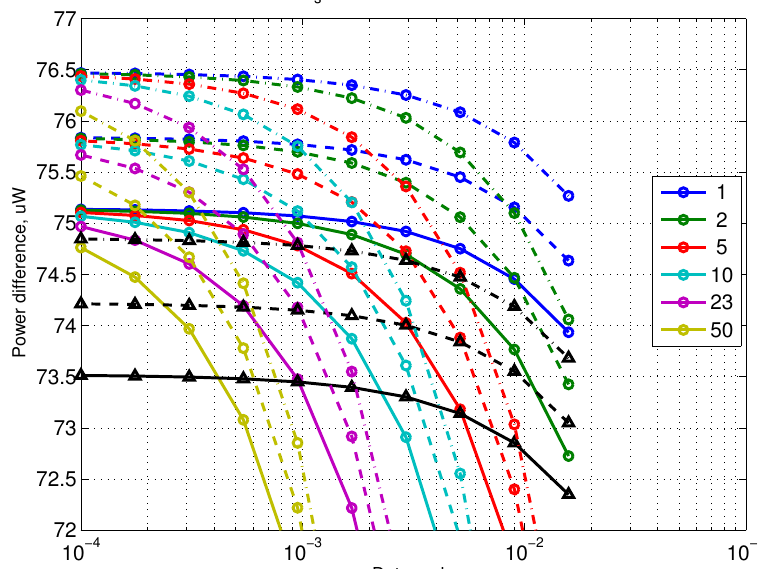
Figure 11. Detailed figure when M t = 1 and M r = 1, power difference while operating. Capacitor ( C s = 0.35 F). Non-WuR in black (without triangles), passive WuR in colors indicating number of nodes for different host duty cycles per node ( β (cid:48) w ). Semi-passive WuR in black with triangles. Line type indicates used SC leakage current model as —: upper , - - -: median, and -.-.-: